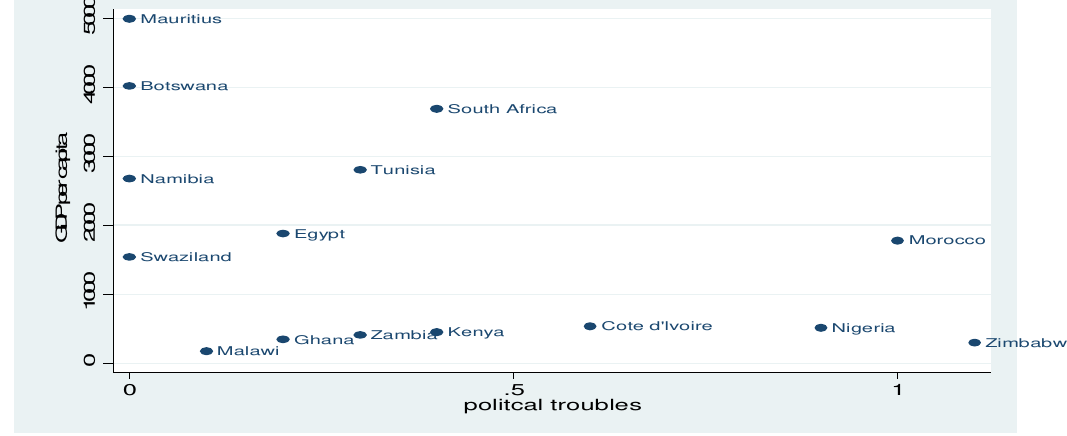
Fig. 7. Political troubles and GDP per